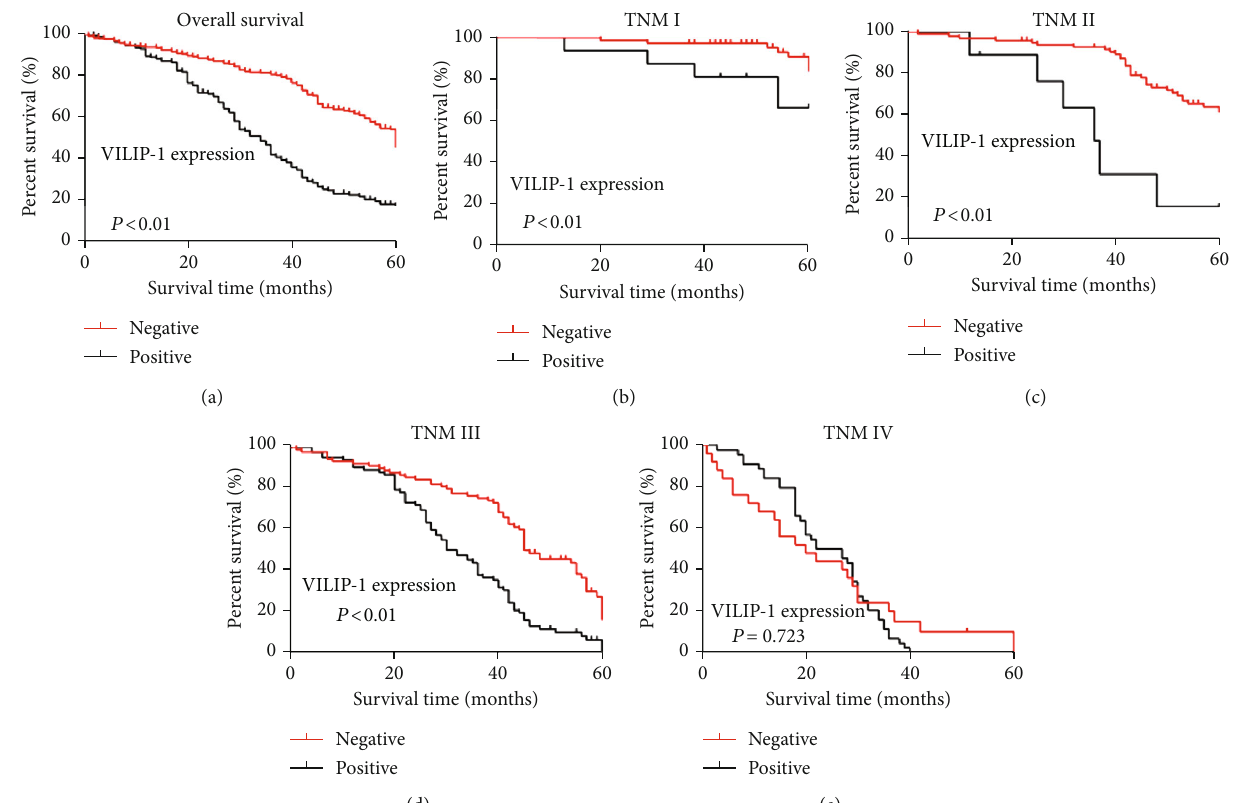
Figure 4: Kaplan-Meier curves with univariate analyses (log-rank) for patients with low VSNL1 expression versus high VSNL1 expression. (a) Cumulative 5-year survival rates for patients with high VSNL1 expression were signi fi cantly lower than in patients with low VSNL1 expression. (b – d) According to the TNM stage, in stages I, II, and III, the patients with high expression of VSNL1 had a signi fi cantly lower 5-year survival rate than those with high expression ( p < 0 : 05 ). (e) In stage IV, the expression of VSNL1 was not correlated with the 5-year survival rate ( p > 0 : 05